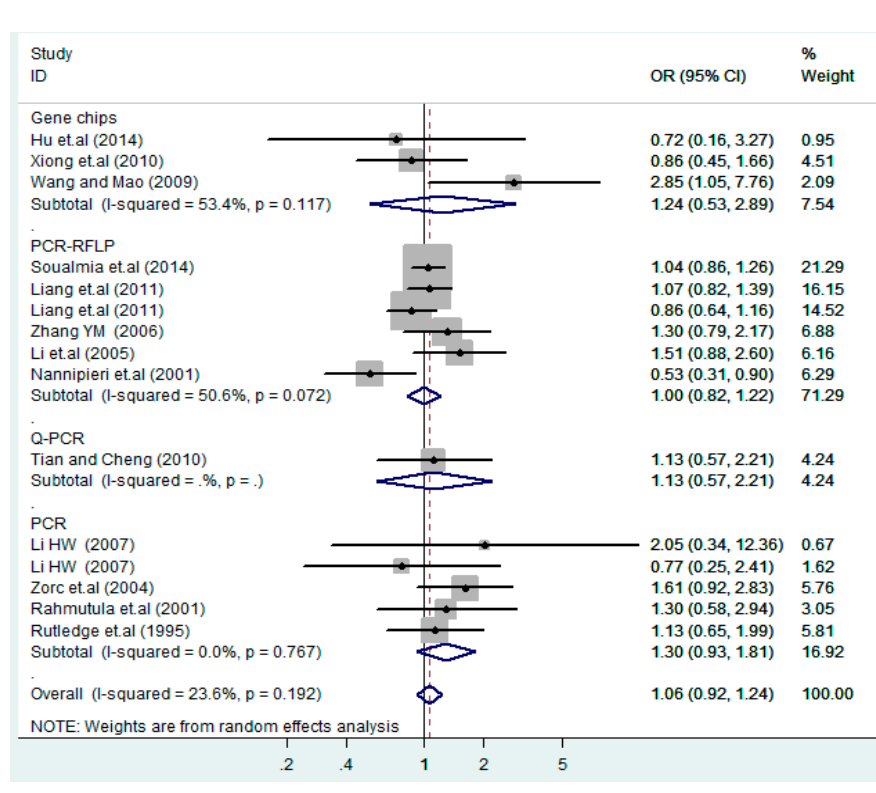
Figure 18. Subgroups in sources of controls of T2238C recessive model CC vs. (TT + TC).